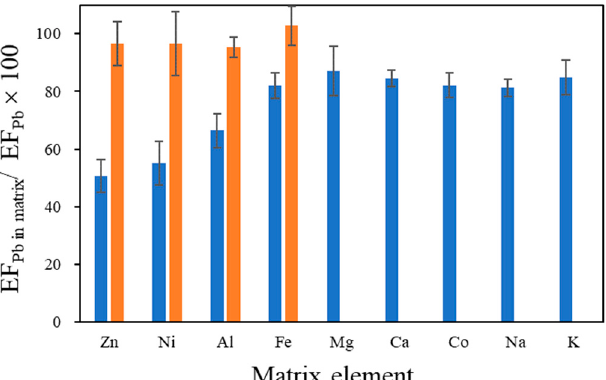
Figure 6. Interference by coexisting elements on the preconcentration of Pb with bare Fe 3 O 4 . Sample: Pb 1 ng · mL − 1 , 100 mL; matrix element; 1000 ng · mL − 1 for all elements (blue) and 100 ng · mL − 1 for Al, Ni and Zn (orange); pH: 5; sorption time (magnetic stirring time): 5 min; ultrasonic desorption agent: 1 mL of 0.3 mol · L − 1 HNO 3 .